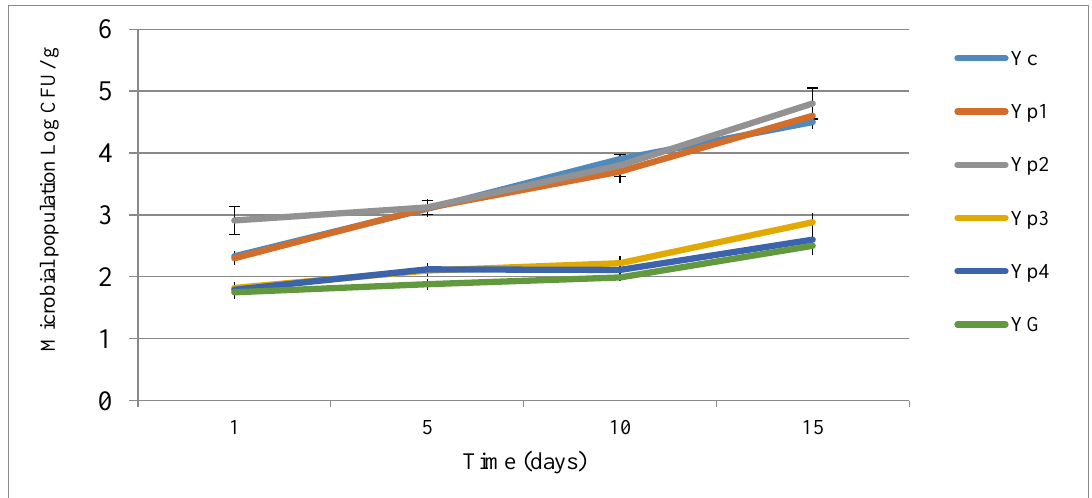
Figure 2. Effect of adding optimized extracted starch on the microbial population of yogurt during storage.